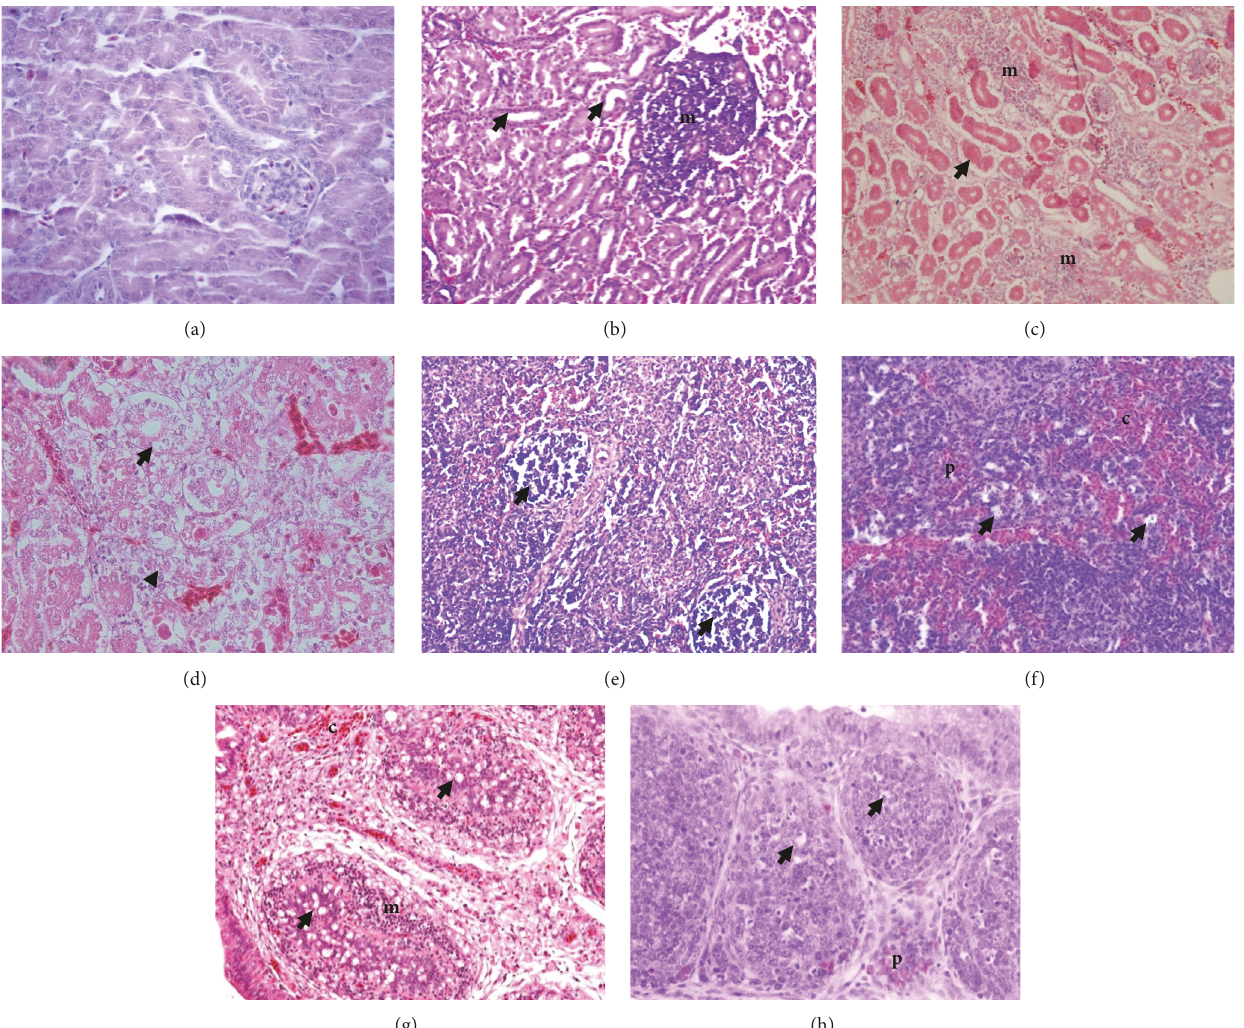
Figure 5: Effect of 5% SAP on the kidney, spleen, and BF histopathology in the broiler chicken fed a diet with naturally contaminated with AF on day 21. The normal appearance of kidney in group II (a); mononuclear cells infiltration (m) in the interstitial with necrosis (arrow) of the tubules epithelial of kidney in group III (b); and group V (c); necrosis (arrow) and degeneration (arrowhead) of the tubules epithelial of kidney in group VI (d); severe depletion (arrow) in the white pulp of the spleen in group III (e); massive congestion (c), depletion of lymphocytes (arrow), with polymorphonuclear cells infiltration (p) in the white pulp of the spleen in group VI (f); depletion of lymphoid follicle (arrow), extensive mononuclear cells infiltration (m), and congestion (c) of the BF in group III (g); irregular size of lymphoid follicles due to depletion of lymphocytes (arrow) with polymorphonuclear cells infiltration (p) in the BF in group VI (h). H&E, 40 × (b); 100 × (d, e, g); 1000 × (a,